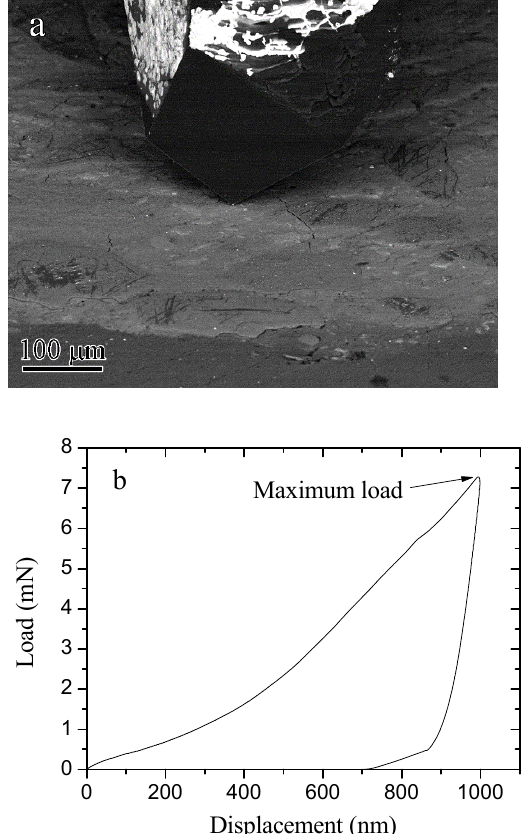
Figure 10. ( a ) BSE image of the indenter on the surface of mortar; ( b ) the load-displacement curve at a certain